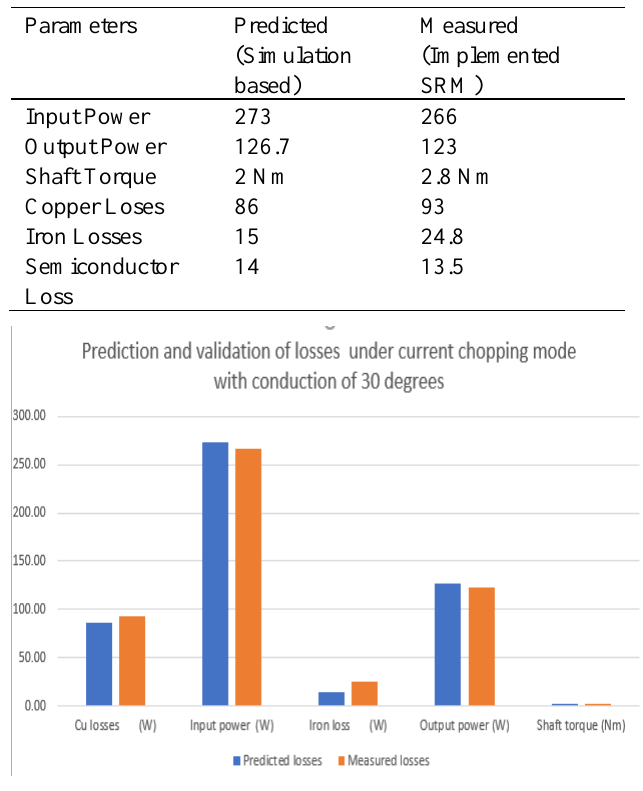
Fig. 9. Production and validation of losses under operating conditions in current-chopping mode at 30 0 conduction